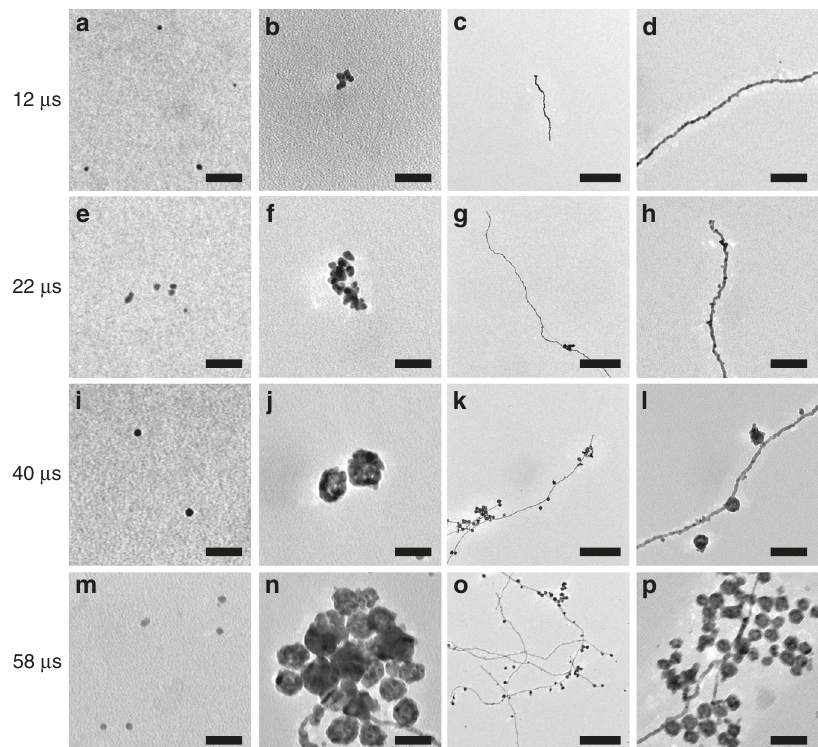
Fig. 4 TEM images at different time points of AuNPs and AuNWs grown in the aqueous microdroplets. Time-course changes in the individual AuNPs ( a , e , i , m ), AuNP aggregates ( b , f , j , n ), and AuNWs ( c , d , g , h , k , l , o , p ). Scale bars for a , b , e , f , i , j , m , n are 40 nm. Scale bars for c , g , k , o are 80 nm. Scale bars for d , h , l , p are 80